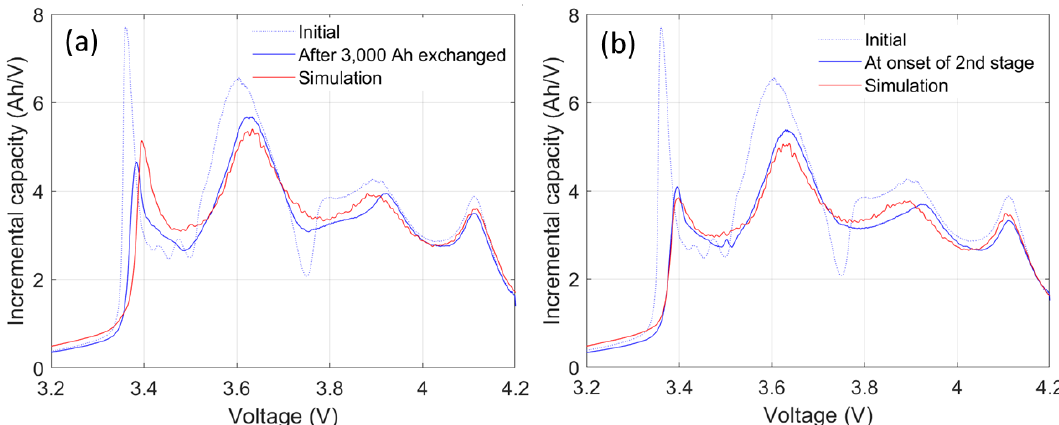
Figure 6. Comparison of experimental and simulated incremental capacity (IC) curves for the NoFR_1 cell ( a ) after 3,000 Ah exchanged and ( b ) at the onset of the second stage.